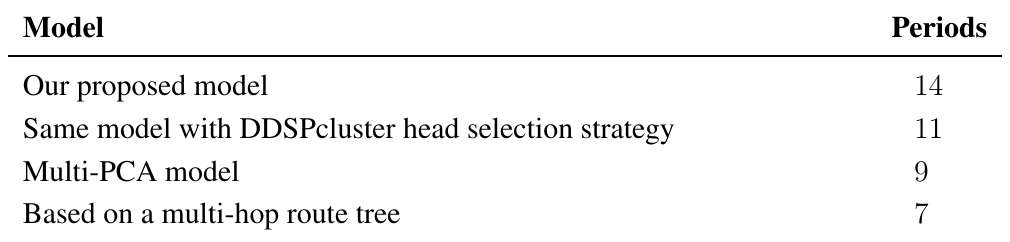
Table 3. Lifetime comparison with the first order radio model.